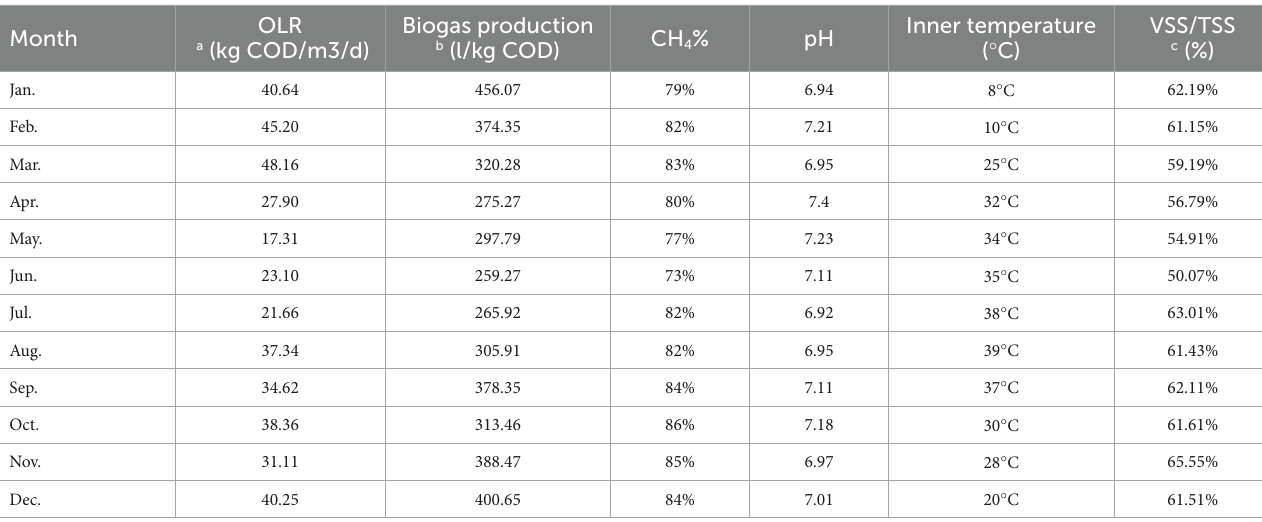
TABLE 1 The detailed information about the operation parameter of EGSB.